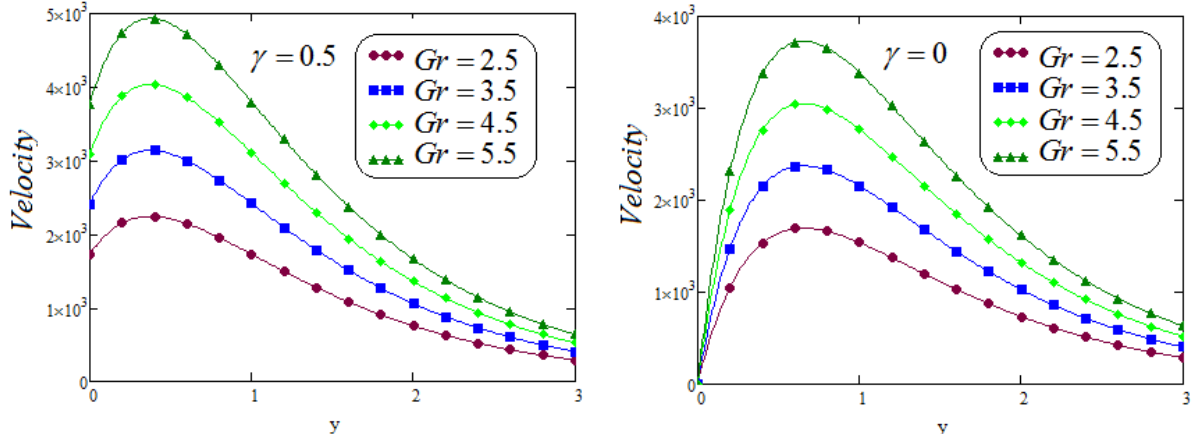
Figure 9. Velocity field under slip conditions as well as the velocity field under no-slip conditions for different Gr values when f ( t ) = sint , t = 1.5, Pr = 0.71, λ 1 = 0.6, λ 2 = 0.2, M = 2.